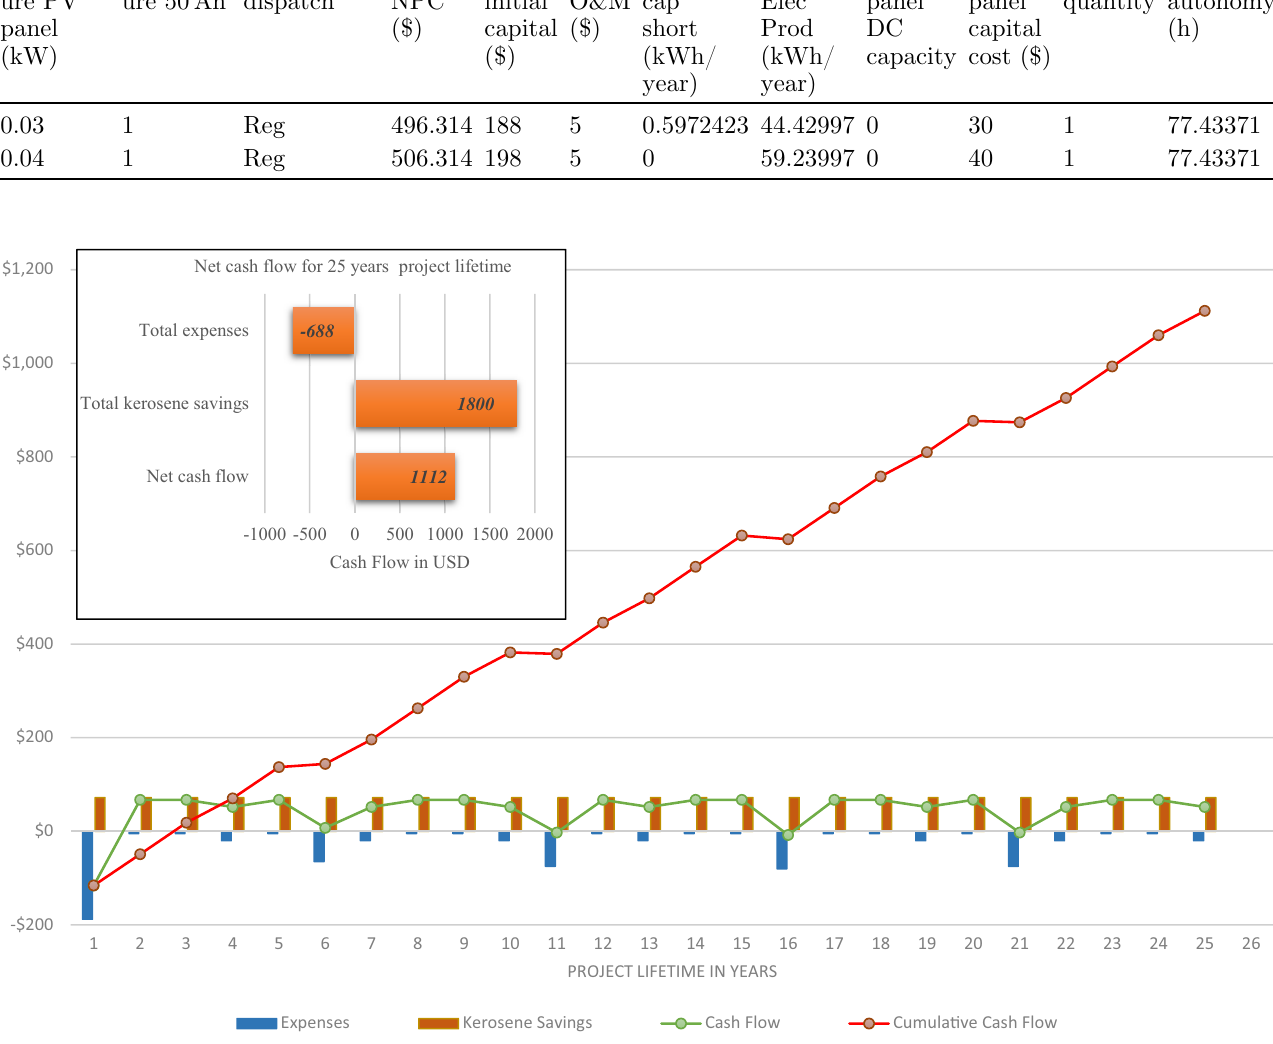
Fig. 5. System lifetime ’ s nominal, cumulative and net cash fl